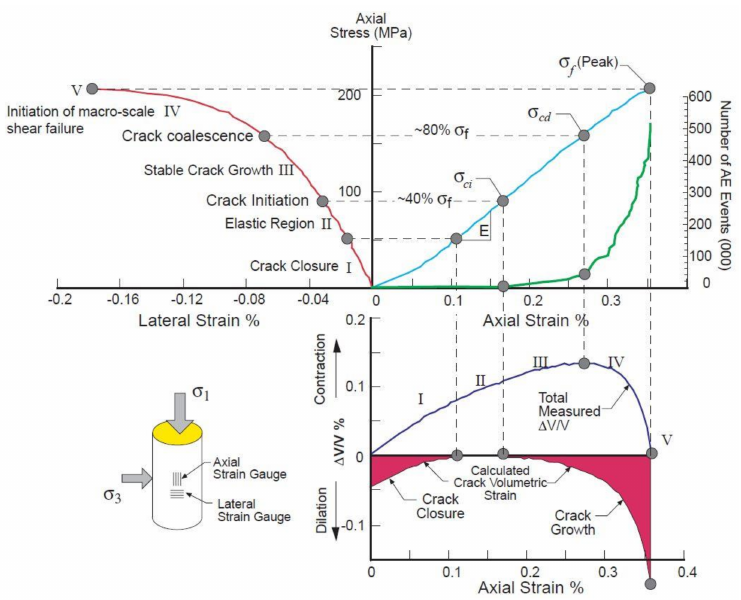
(Figure 1). Crack closure stress is defined as the point at which the axial stiffness curve changes from nonlinear to linear or where the crack volumetric strain converges to zero. The crack initiation stress is defined by the onset of stable crack growth and is indicated as the point at which the crack volumetric strain deviates from zero. Therefore, the range between crack closure and crack initiation is considered as the region showing elastic behavior. Meanwhile, the crack coalescence is referred to as the point where large irregularities in the volumetric stiffness occur. The crack damage stress is characterized by unstable growth of crack and associated with the reversed region in the curve of the total volumetric strain [1,5].